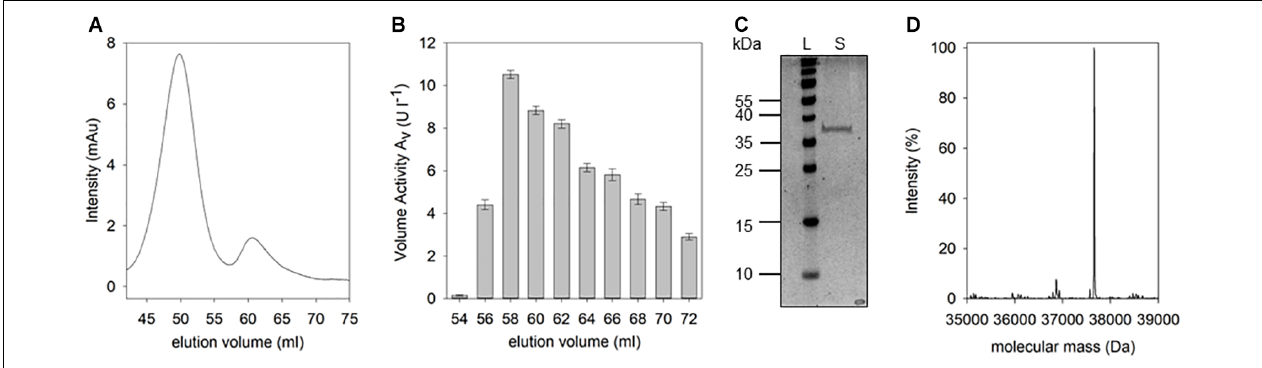
FIGURE 4 | Isolation and purification of D -Arg specific D SP. The supernatant of B. thuringiensis was purified as described. After size exclusion chromatography (A) the volume activity within the fractions was determined via fluorescence measurements using IQFS (B) (200 µ M IQFS, reaction time 10 min). After pooling and concentrating D SP-active fractions, the resulting sample was analyzed via SDS-PAGE (C) (12.5% SDS-PAGE, silver staining, PageRuler TM Prestained Protein Ladder [L], concentrated fractions [S]). Mass spectrometic analysis of the purified protein reveals a molecular mass of the D -Arg specific D SP of 37,661 Da (D)